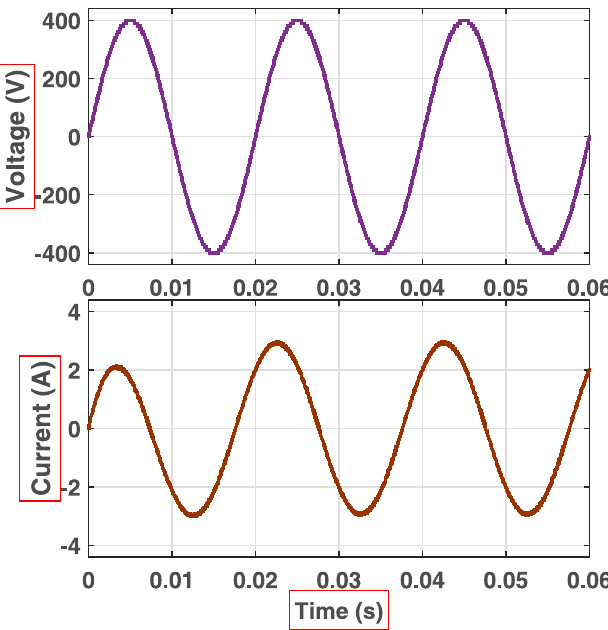
Fig 18. Simulation waveforms (voltage and current) at the output of 81-level MWMLI for RC-load.